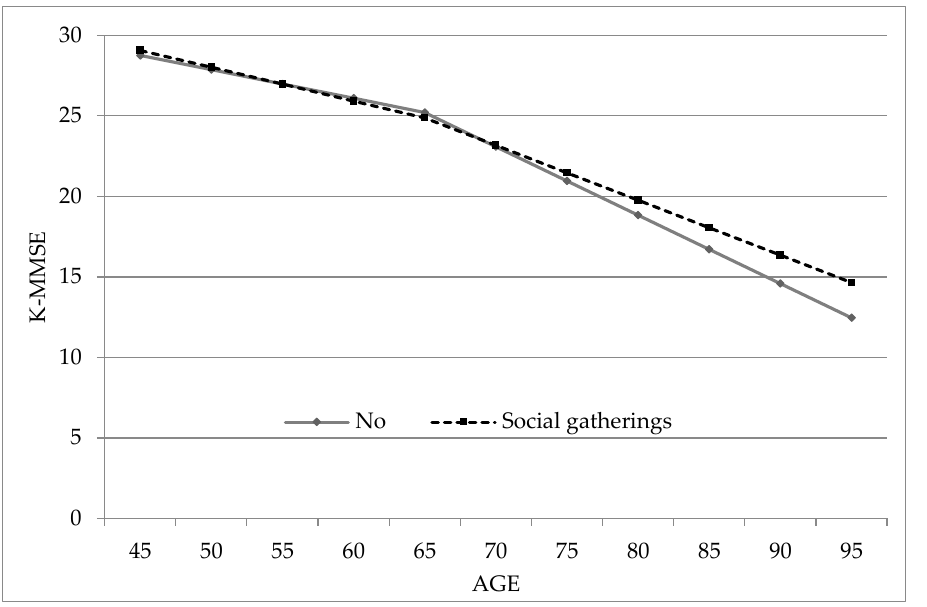
Figure 1. Change in K-MMSE over age based on participation in social gatherings among women.